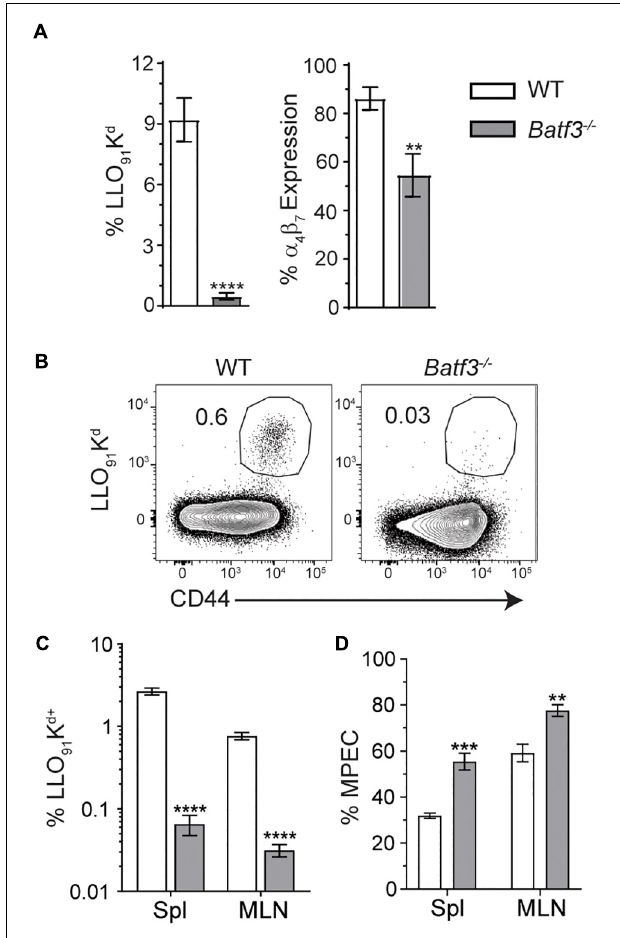
FIGURE 6 | Batf3 − / − mice exhibit defects in InlA M Lm -specific adaptive immune responses after foodborne infection. WT and Batf3 − / − mice were infected with 2 × 10 9 CFU InlA M Lm 10403s. (A) At 8 dpi, blood was collected from the tail veins of both groups of mice, and the samples were processed and stained for flow cytometry. LLO 91 -K d tetramer staining was utilized to analyze InlA M Lm -specific CD8 T cell responses, while α 4 β 7 indicated gut homing potential. (B–D) At 9 dpi, spleens and MLN were analyzed by flow. LLO 91 -K d tetramer staining indicated InlA M Lm -specific CD8 T cells. MPEC were identified as KLRG-1 − CD127 + LLO 91 -K d + CD8 T cells. (B) Representative tetramer staining is shown. Data are representative of at least 2 independent experiments with 7–8 mice per group. Unpaired T -tests were used to compare data sets: ** p < 0.01; *** p < 0.001; **** p <